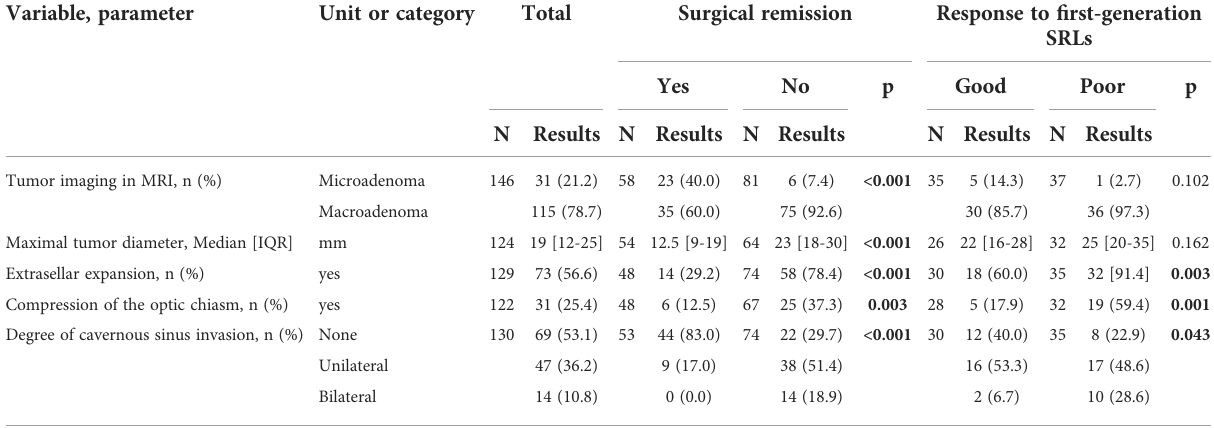
TABLE 2 Imaging presentation of the study